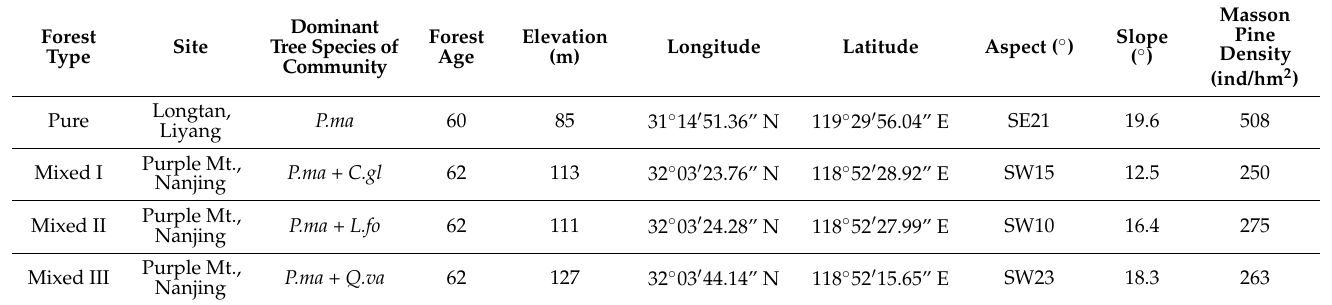
Table 1. Data of Masson pine population and their environmental conditions in southern Jiangsu, eastern